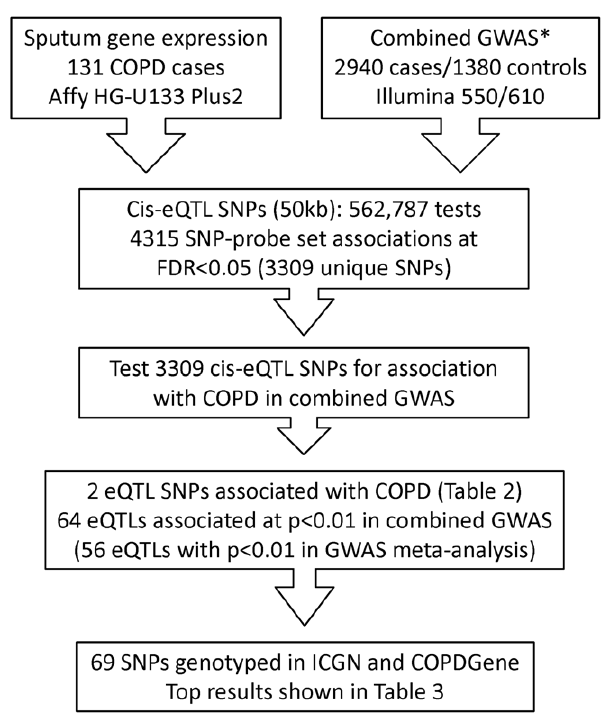
Figure 1. Overview of integrative genomics data analysis. *Combined genomewide association study (GWAS)=Evaluation of COPD Longitudinally to Identify Predictive Surrogate End-points (ECLIPSE), Bergen Norway, and National Emphysema Treatment Trial (NETT)-Normative Aging Study (NAS) [11]. COPD=chronic obstructive pulmonary disease. eQTL = expression quantitative trait locus. FDR=false discovery rate. ICGN=International COPD Genetics Network. SNP=single nucleotide polymorphism.